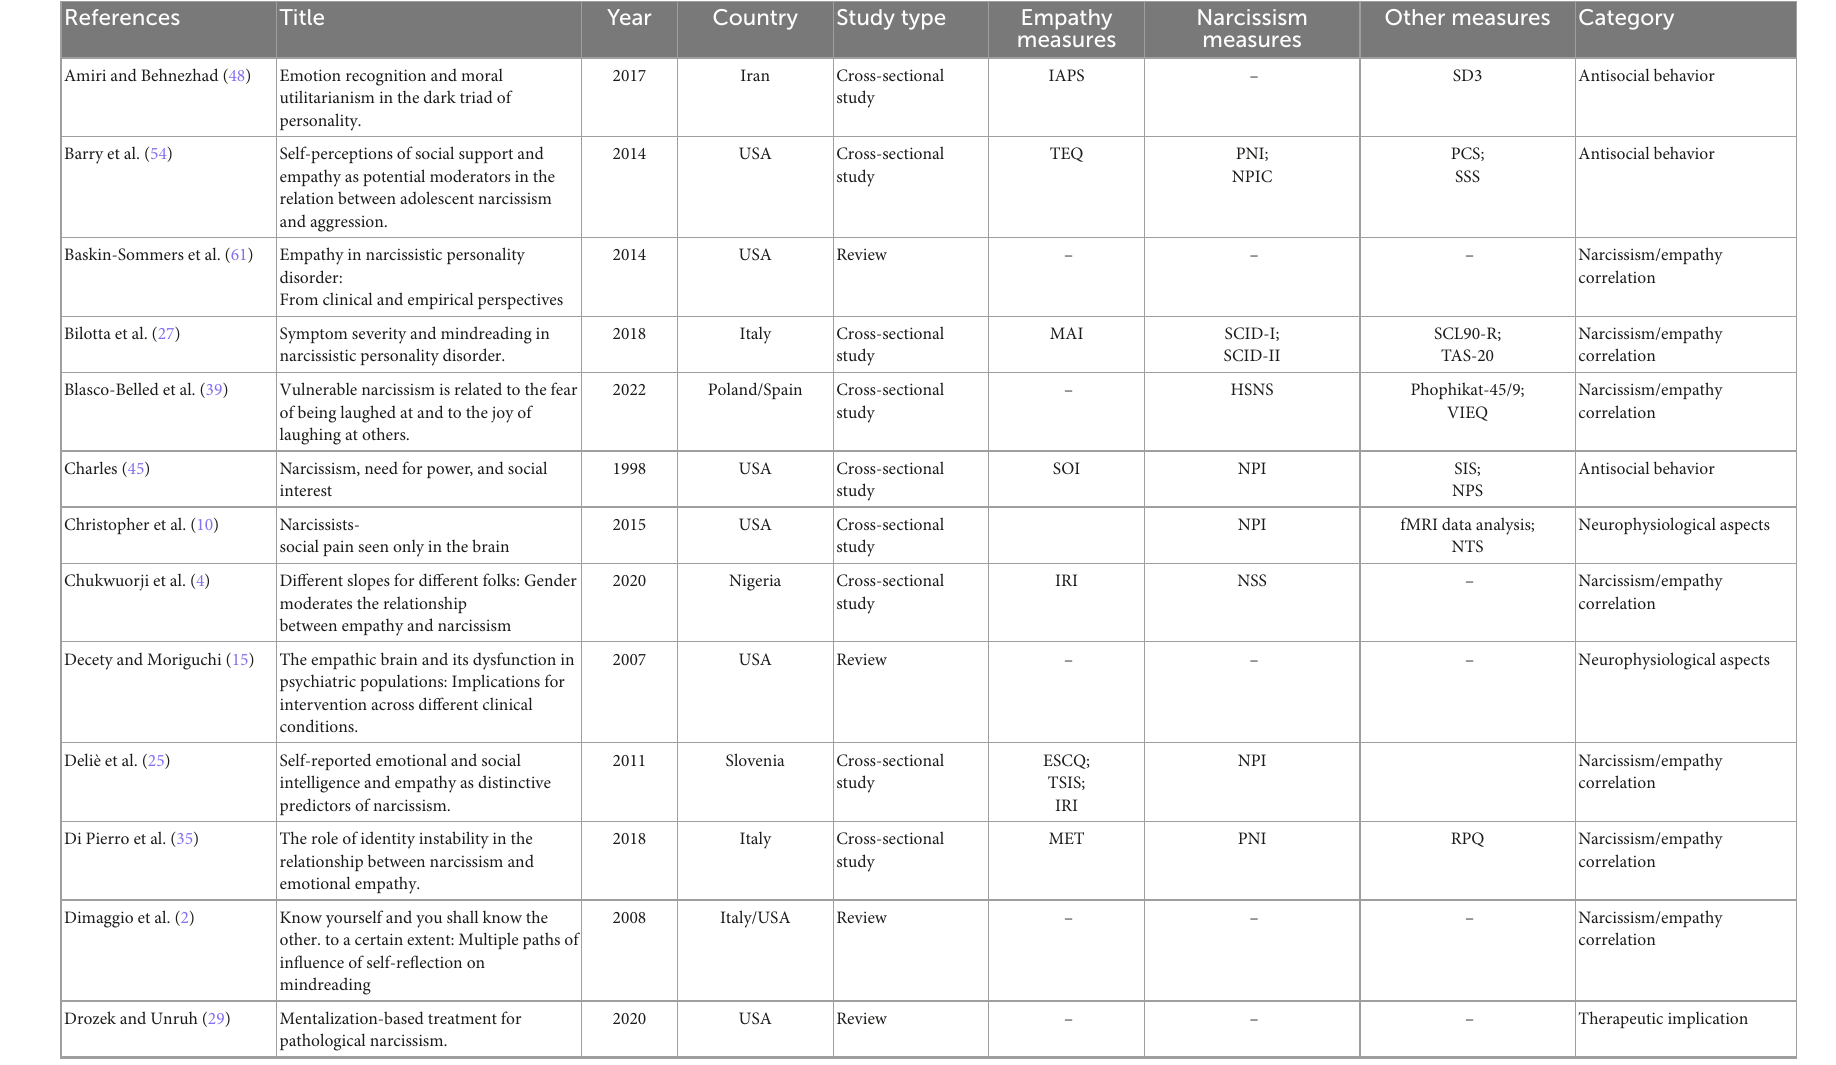
TABLE 1 Studies included in qualitative